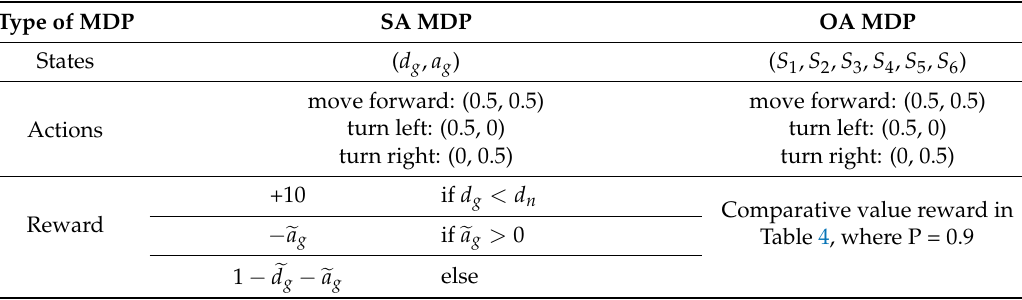
Table 1. Definitions of Subgoal-Approaching (SA) and Obstacle-Avoiding (OA) Markov Decision Processes (MDPs).